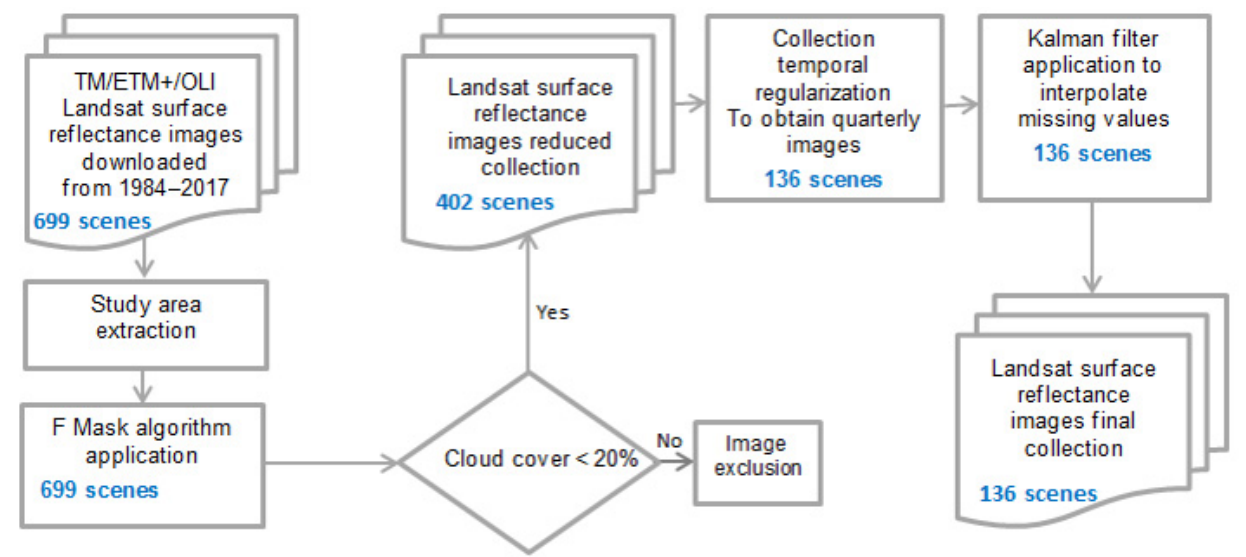
Figure 2. The workflow of the Landsat images preprocessing from the batch download of the data to the reservoir mask application on Landsat images. At the bottom of the squares, the number of images used (in light blue) is reported.